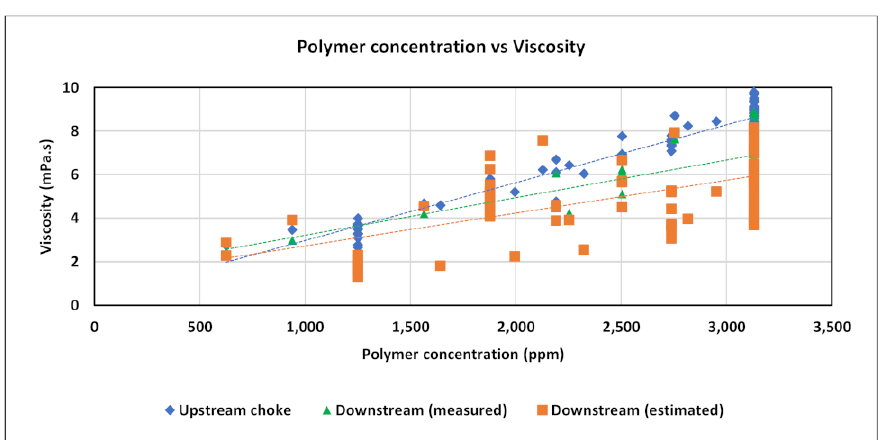
Figure 7. Polymer viscosity measurements across the shearing device choke and estimated down- stream